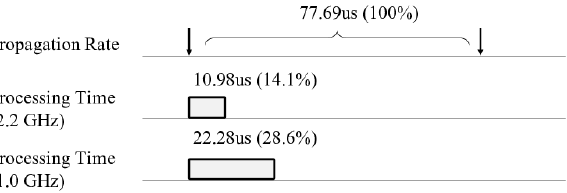
Figure 3. Comparison of the propagation and processing rates of a write operation.